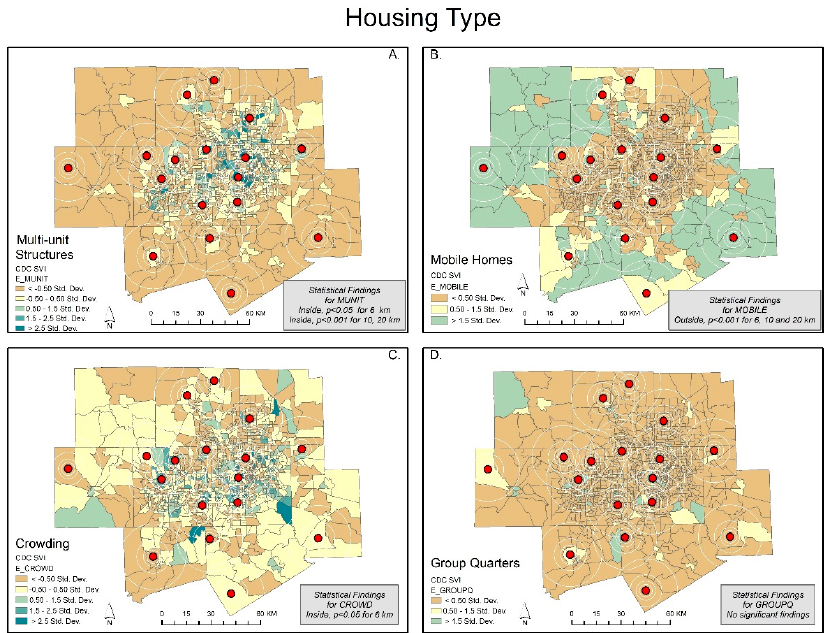
Figure 4. Dallas—Fort Worth: SD classification scheme of social variables for housing type. The CDC/ATSDR SVI variables include Figures; ( A ) multi-unit structures; ( B ) mobile homes; ( C ) crowding; ( D ) group quarters.